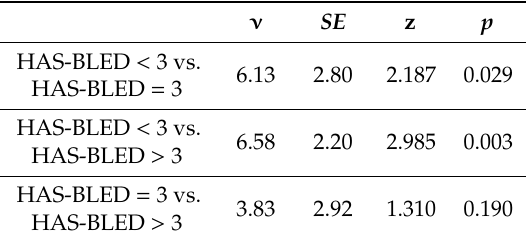
Table 3. The log-rank test resulted in subgroups split according to di ff erent HAS-BLED values for the composite endpoint, including death for any reason.